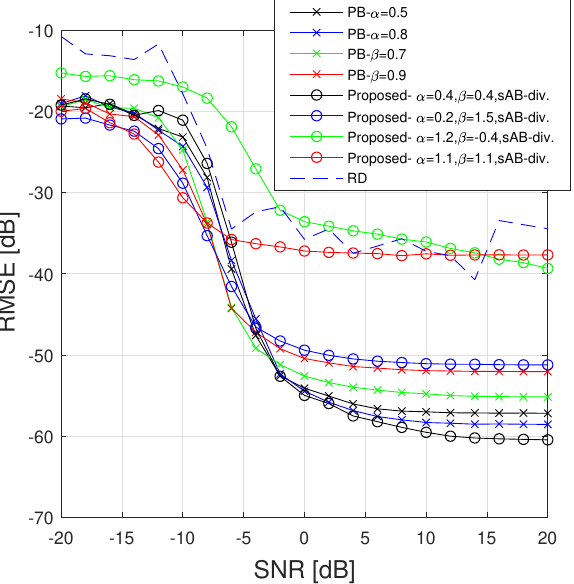
Figure 5. RMSE (in dB) of the IF (averaged over 100 realizations of noise) obtained with the different competing methods for the component C 1